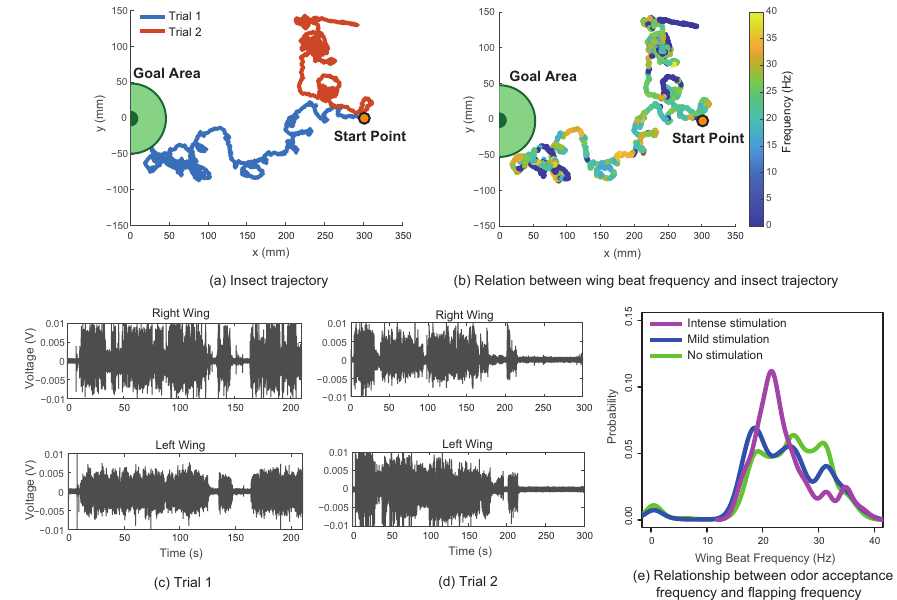
Figure 9. Results for the odor search behavior of a silk moth. The trajectory of insect movement during odor search behavior is shown in ( a ), and the corresponding wingbeat frequency is shown in ( b ). The measured sensor signals for both the right and left wings during Trials 1 and 2 are shown in ( c , d ), respectively. The probability of the wingbeat frequency for three different types of pheromone simulations is shown in ( e ), where an intense stimulation indicates stimulation frequencies greater than 1 Hz, a mild stimulation refers to a frequency between 0.5 and 1 Hz, and no stimulation indicates less than 0.5